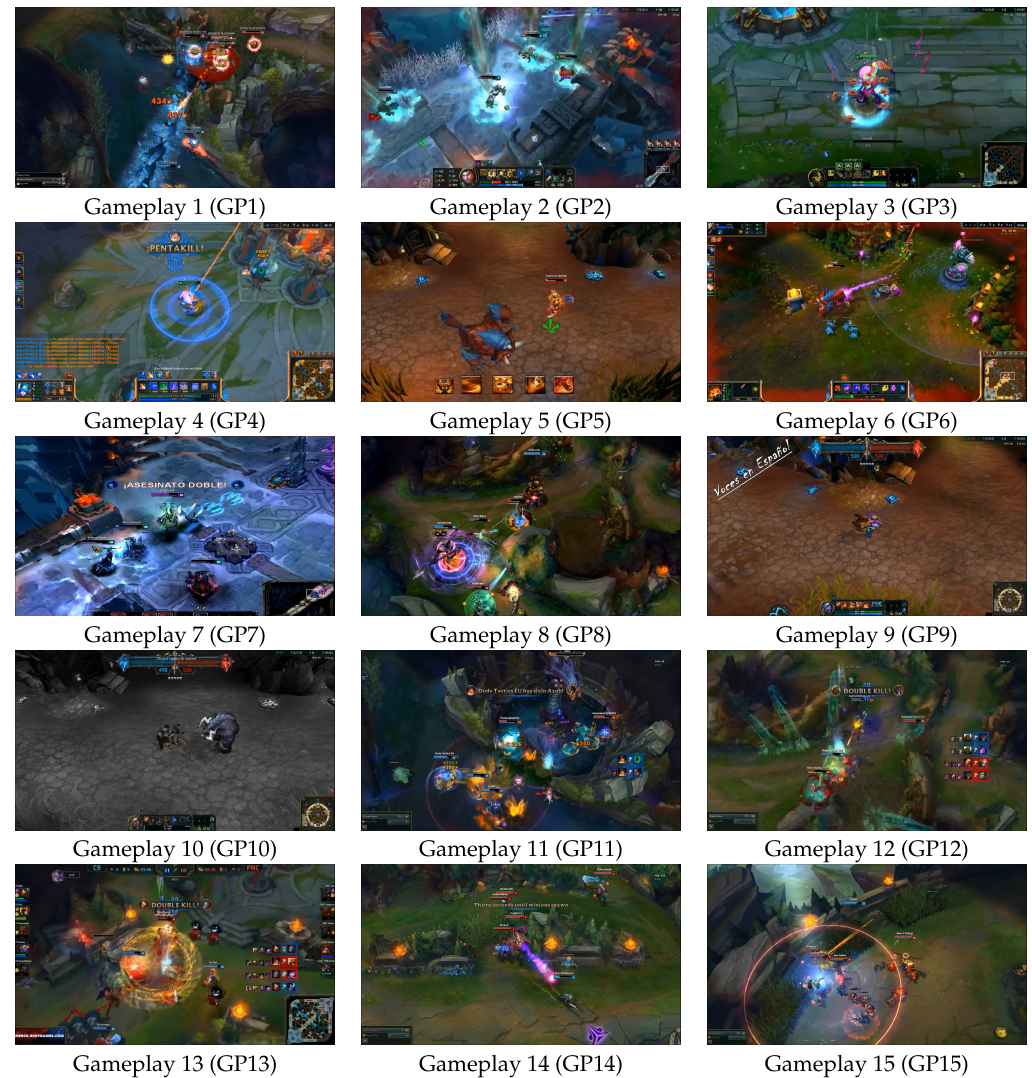
Figure 1. A representative image from all 15 gameplay (GP) videos used in the